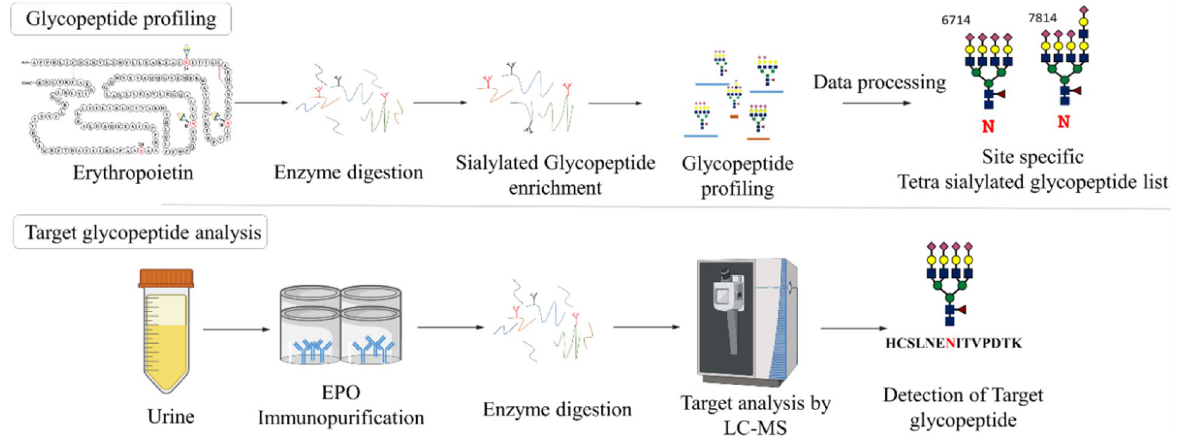
Figure 1. Experimental workflow for glycopeptide profiling and the target analysis method. Profiling for sialylated glycopeptides using TiO 2 enrichment and target analysis with immunopurification were performed. PMI-Byonic (v3.10.2) pGlyco Site Glycan structure